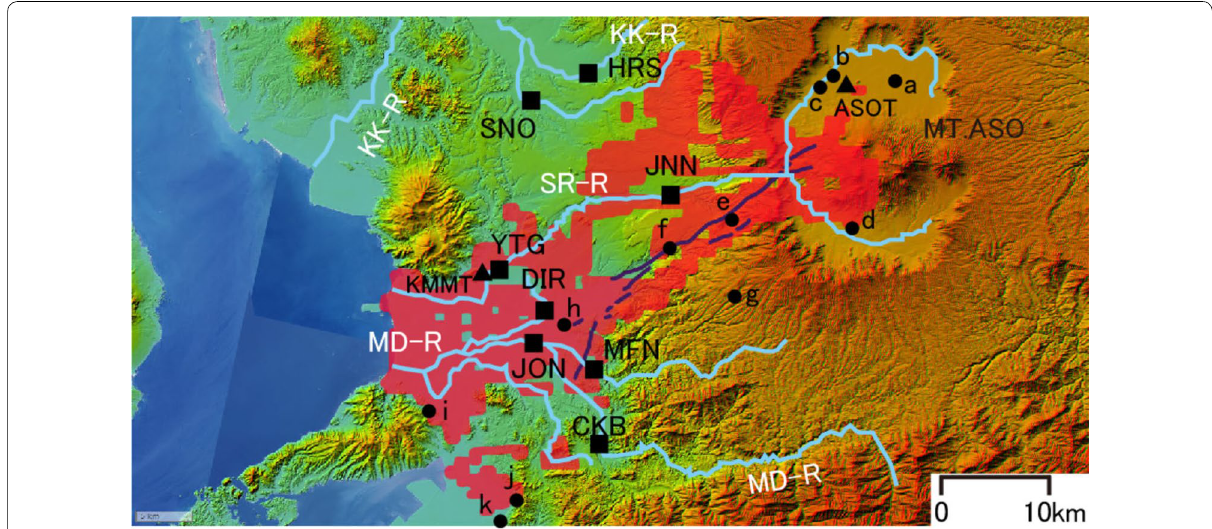
Fig. 1 Map of the study area. Red areas indicate strong ground motion, where the seismic intensity of the main shock of the 2016 Kumamoto earthquake was in the upper 6 range on the JMA scale (Japan Meteorological Agency 2019a). Dark blue lines indicate surface ruptures formed during the earthquake (Shirahama et al. 2016). Light blue lines indicate the three major river systems in the study area: Kichichi River system (KK-R), Shira River system (SR-R), and Midori River system (MD-R). Solid triangles indicate weather stations: Kumamoto Local Meteorological Observatory (KMMT) and Aso-otohime Automated Meteorological Data Acquisition System (ASOT). Solid squares indicate streamflow rate observation stations: SNO, HRS, JNN, YTG, DIR, JON, MFN, and CKB. Solid circles indicate observed springs: a:YKI, b:TNB, c:KYH, d:IKN, e:SOY, f:SOI, g:YSM, h:SMR, i:TDR, j:MTR and k:DMZ. The background map was derived from the Geospatial Information Authority of Japan